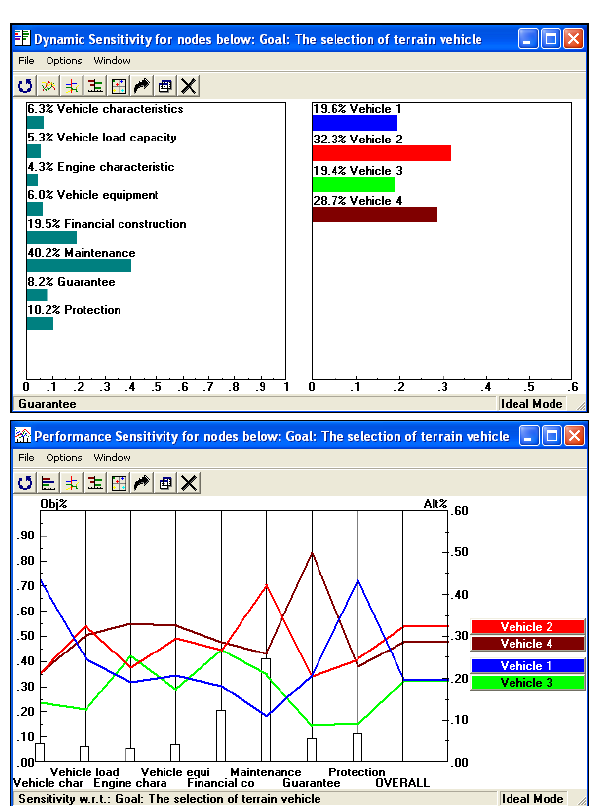
Figure 17. Maintenance is significantly the most important